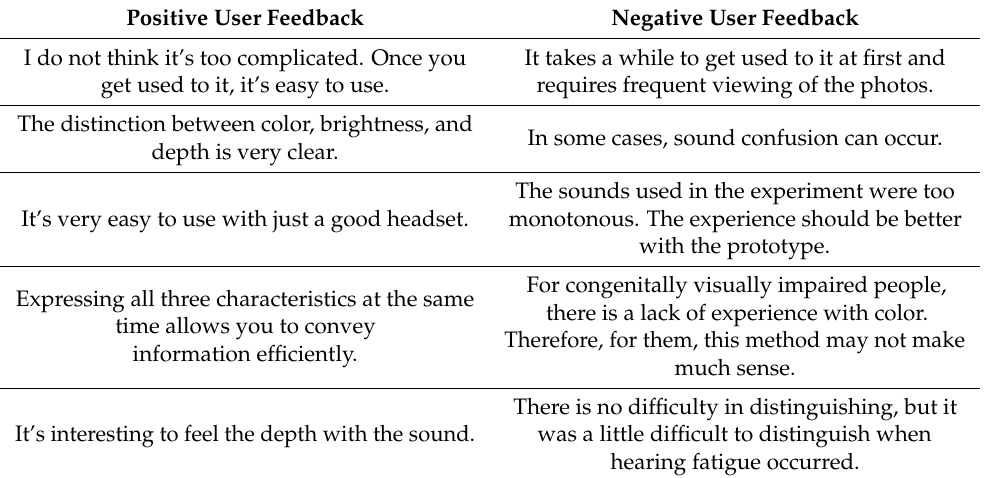
Figure 8. Scores obtained for UX test questions. Table 12 lists the participants’ positive and negative feedback. Table 12. Positive and negative user feedback from the UX